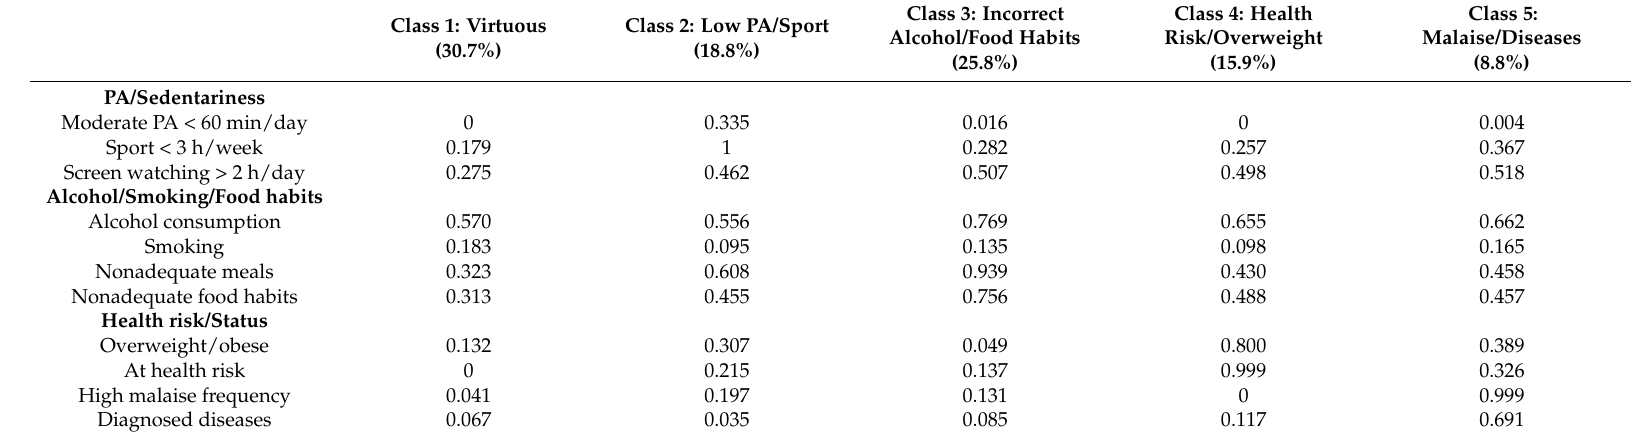
Table 3. Conditional probabilities and descriptive statistics of unhealthy lifestyles and health risks/unhealthy status across classes of fitness-related risk